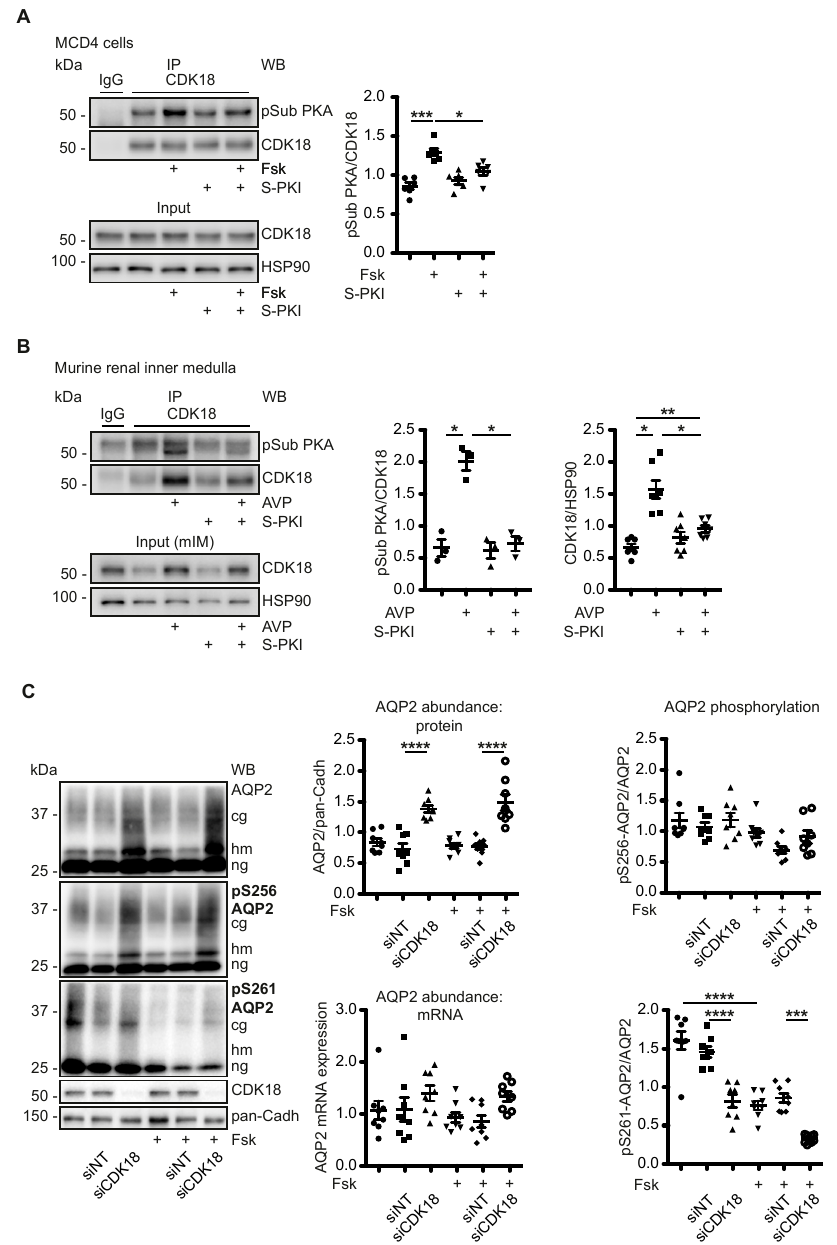
Figure 2. PKA modulates CDK18, which controls AQP2 phosphorylation at S261 and its abundance. ( A ) MCD4 cells or ( B ) murine inner medullae homogenates were left untreated, treated with forskolin (Fsk) or AVP and where indicated with a membrane-permeant version (stearate-coupled) of the PKA-specific heat-stable inhibitor peptide (S-PKI). CDK18 was immunoprecipitated (IP) and detected by Western blotting. The PKA-phosphorylated CDK18 (pSub CDK18) was detected with phospho-PKA substrate antibody. As a control, precipitations were carried out with unrelated IgG. As loading controls in input samples, HSP90 was detected. The Western blots were densitometrically evaluated. Shown are representative results from n ≥ 3 per condition. ( C ) MCD4 cells were left untransfected or transfected with non-targeting (siNT) or CDK18 siRNA, and stimulated with forskolin (Fsk) as indicated. AQP2 protein abundance and phosphorylation of its S256 and S261 were detected by Western blotting with specific antibodies. cg: complex glycosylated, hm: high-mannose, ng: non-glycosylated AQP2. Shown are representative results from n ≥ 8 per condition. The signals were densitometrically analysed. AQP2 mRNA expression was evaluated by PCR. Significant di ff erences are indicated, * p < 0.05, ** p < 0.01, *** p < 0.001, **** p <